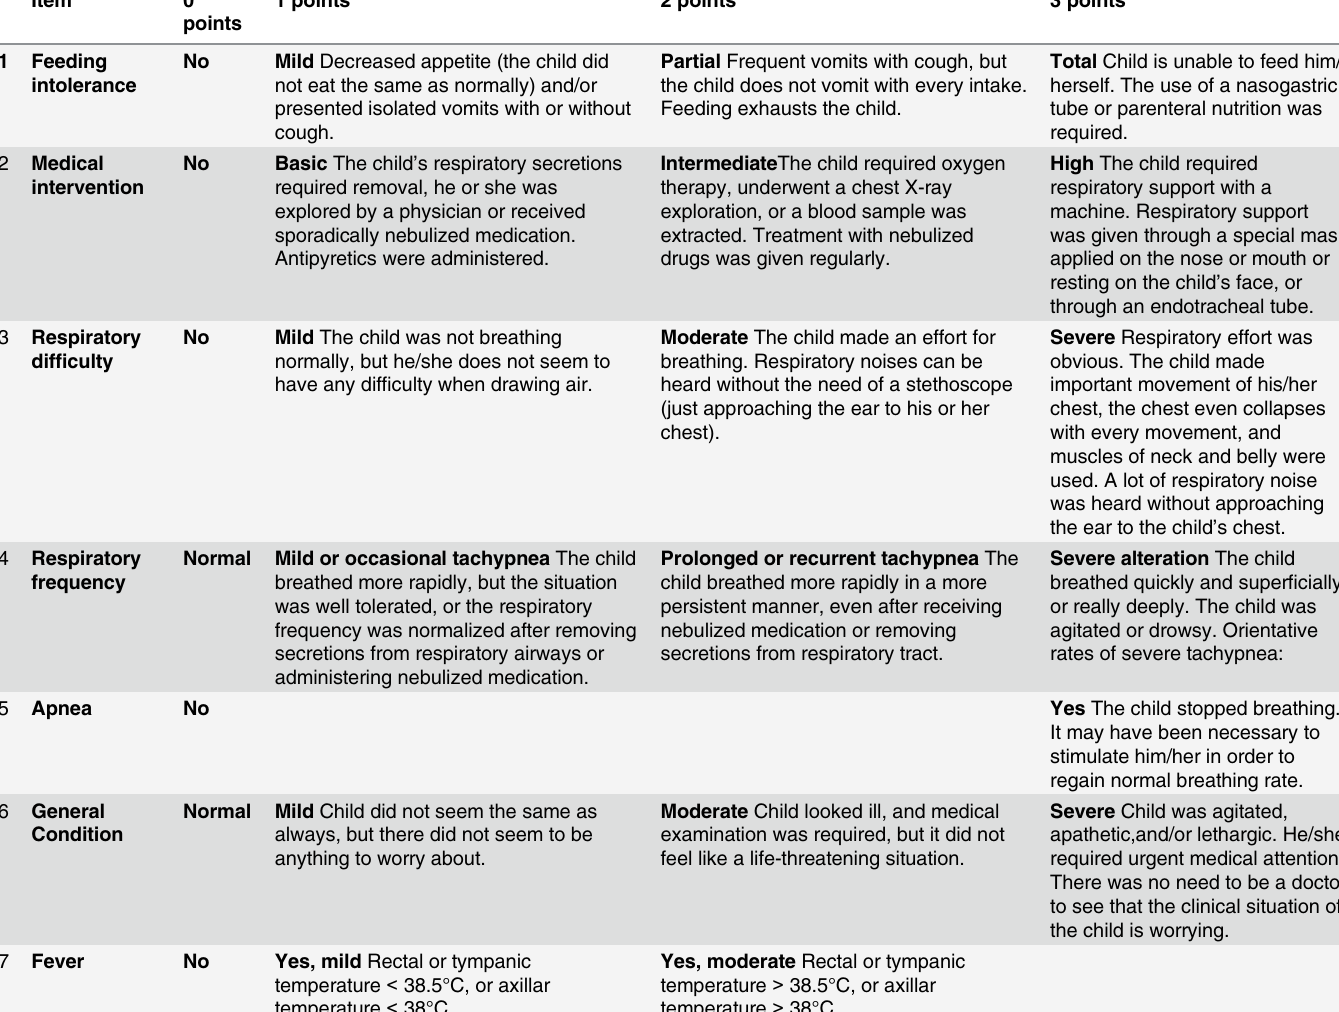
Table 2. Adapted version of the ReSVinet scale for parental